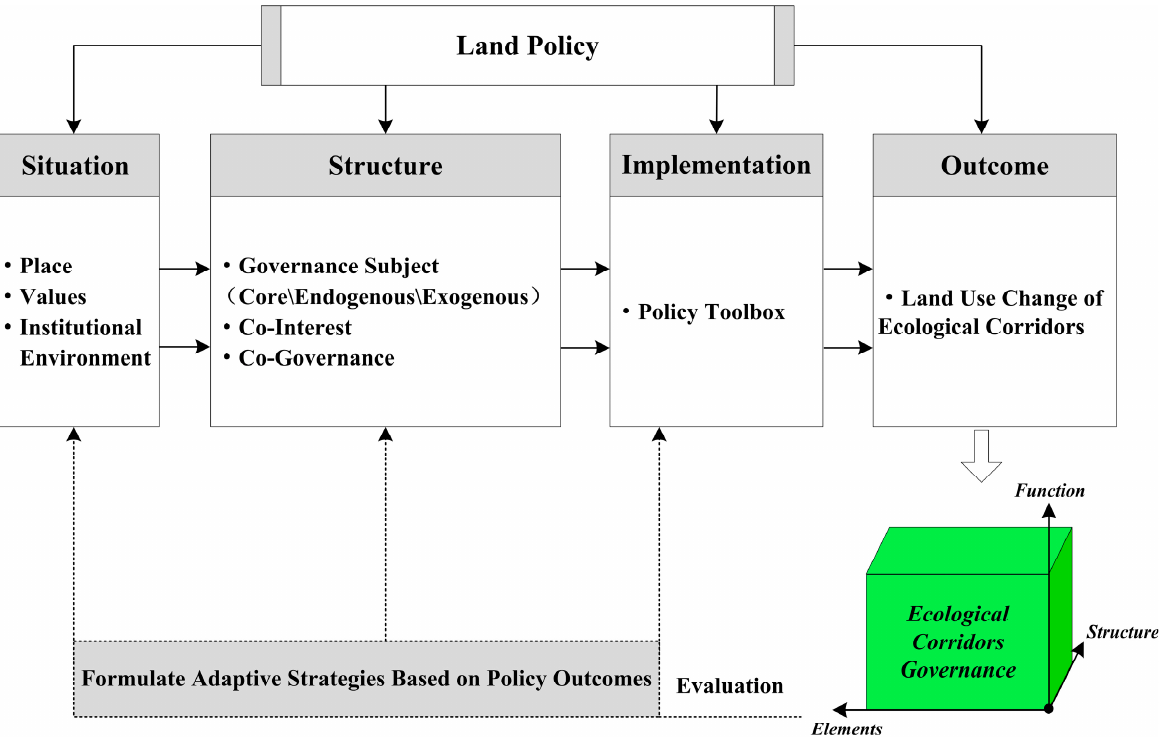
Figure 1. Theoretical framework: SSIO.